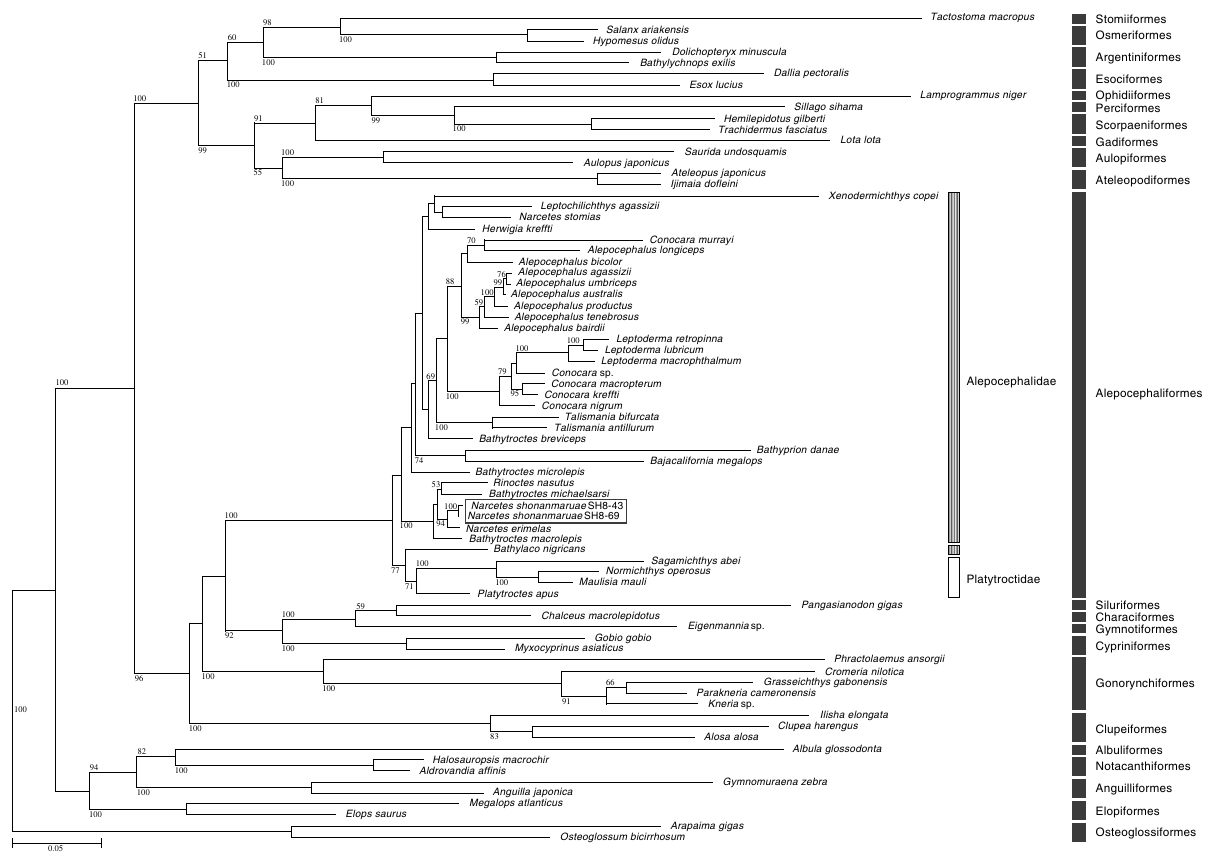
Figure 4. Phylogenetic placement of Narcetes shonanmaruae based on amino acid sequences from 13 protein-coding genes of the mitogenome. A maximum likelihood (ML) tree is shown. Scale bar represents 0.05 nucleotide substitutions per sequence position. Bootstrap values are shown for each branch. Narcetes shonanmaruae is